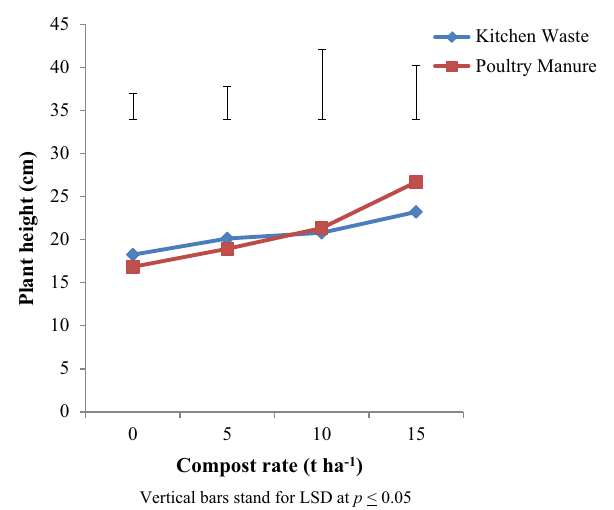
Fig. 1 Responses of Corchorus height to rates of compost amend- ment. Vertical bars stand for LSD at p ≤ 0.05